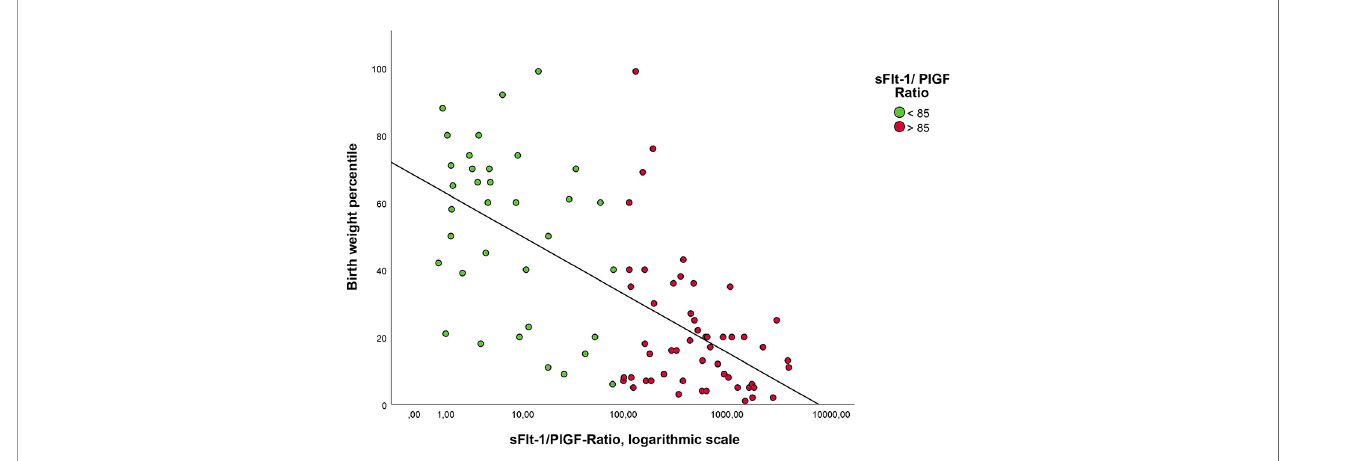
FIGURE 3 | Correlation of birth weight percentile with sFlt-1/PlGF ratio. Notes. The ratio has been logarithmized for